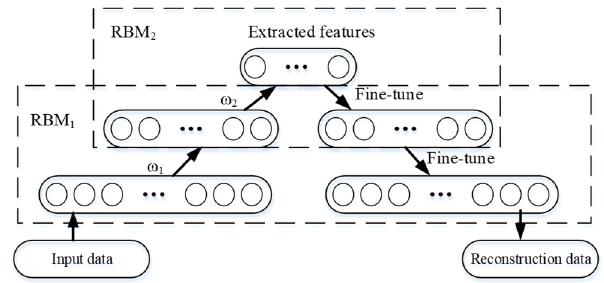
Figure 2. Unsupervised fine-tuning of DBN.